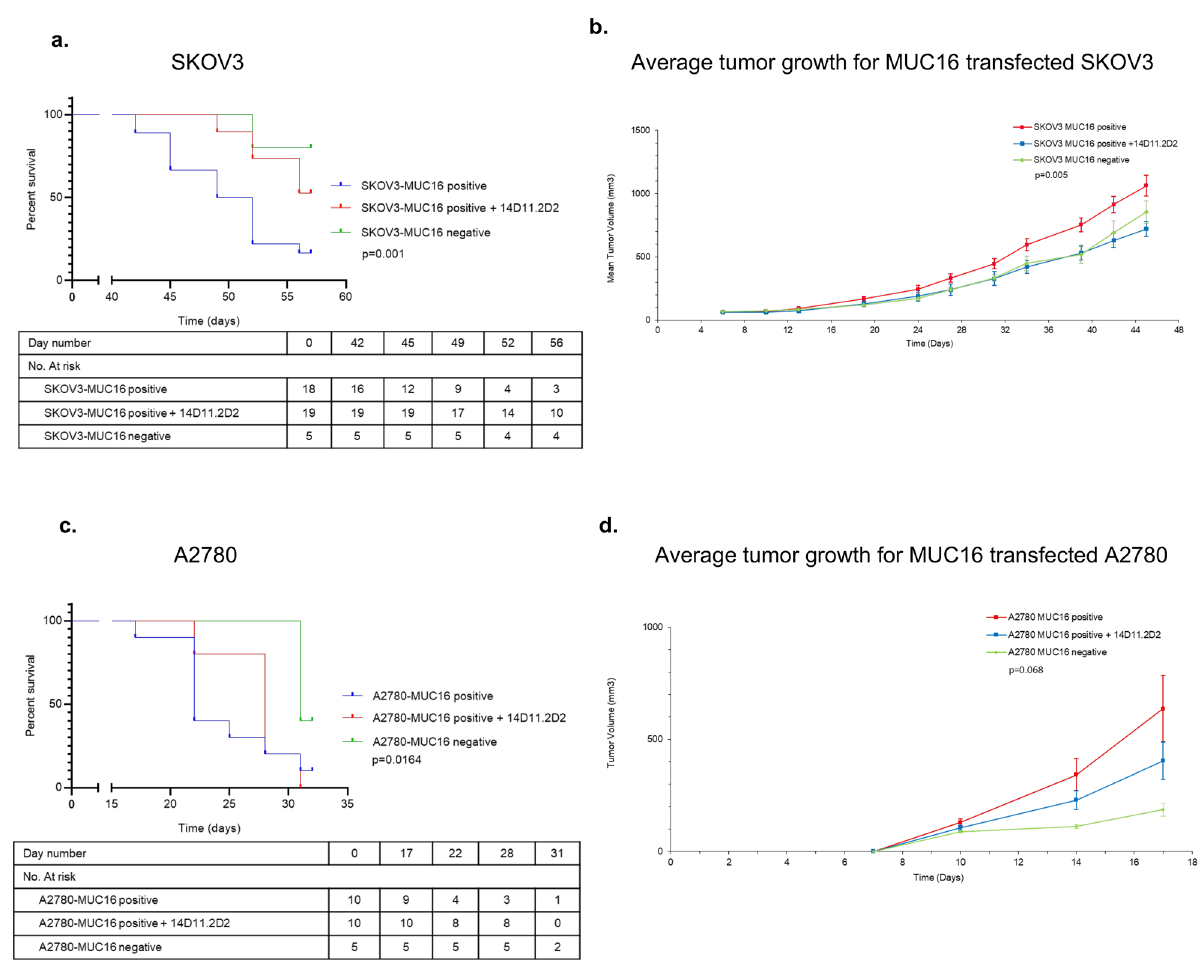
Figure 5. Therapeutic effects of Gal3 blockade in vivo. Kaplan–Meier survival curves for mice implanted with SKOV3 c344 , A2780 c344 , or MDA-MB-231 tumors are shown. ( a ) For mice implanted with SKOV3 c344 tumors, the median survival time for the untreated group was 49 days (95% CI, 45.3–52.6), while the median survival for the group treated with 14D11 and for the group implanted with MUC16 negative SKOV3 cells was not reached after 56 days when the experiment was terminated ( p = 0.001). ( b ) Average tumor growth for animals implanted with SKOV3 cells. ( c ) For the group implanted with A2780 c344 cells, the median survival time for the untreated group was 22 days (95% CI, 19.6–24.4), while the median survival time for the group treated with 14D11 was 31 days (95% CI, not estimable), and median survival was not reached for animals implanted with MUC16 negative A2780 cells ( p = 0.0164). ( d ) Average tumor growth for animals implanted with A2780 mouse was sacrificed. The splenocytes of this mouse were fused with a hybridoma fusion partner, according the protocols of the MSKCC monoclonal antibody facility. In a third campaign, the antibodies were produced by immunizing the mice with Peptide 1 and Peptide 5. Peptide 5 was a custom peptide similarly synthesized from the N-terminus of Gal3 (MADNFSLHDALSGSGNPNQGWPG; Atlantic Peptides; Lewisburg, PA). Peptide 9 was a custom peptide that was synthesized from the N-terminus of Gal3 (CMADNFSLHDALSGSGNPNQGWPG; Atlantic Peptides; Lewisburg, PA) which has a Cysteine at the N-terminus to conjugate with KLH as described above, creating the KLH-Peptide 9 used for immunization. The mice were screened similar to campaign 2 with the addition of being screened for reactivity against Peptide 5. Functional assays. Once the purified anti-Gal3 supernatants were obtained, they were screened for their activity using binding, invasion, and anti-tumor assays, as described in Fig. 3A. Antibodies deemed to be poten- tially useful were subcloned, retested and stored for future use. ELISA. Purified antibodies that bound to Gal3 were confirmed by ELISA. For this, 2 strategies were used. The first utilized a plastic 96-well microplate coated with recombinant human Gal3 (rGal3) protein (Abcam; Cam- bridge, MA), synthetic peptide (Gal3 CBD—Peptide 1; Gal3 NH2 terminus—Peptide 5 ), Mouse Gal3, human Galectin-1 (Gal1), Galectin-7(Gal7), Galectin-8 (Gal8), or Galectin-9 (Gal9) (Sigma) and an isotype-specific secondary antibody conjugated Horseradish-Peroxidase (HRP) for detection. As there was concern that Gal3